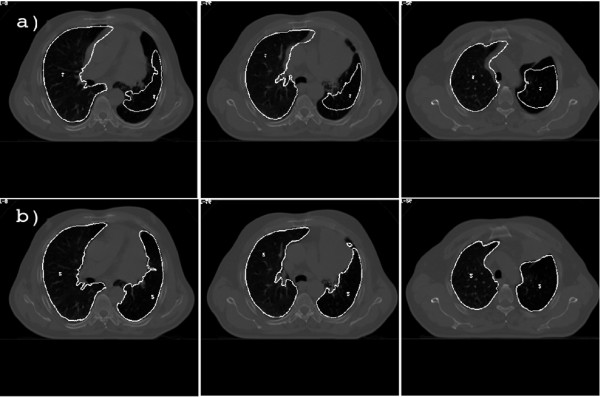
Comparison of lung contours correspondence. kVCT slices for patient 1 with superimposed lung contours extracted from the MVCT after a sole rigid realignment (a) and the elastic method (b). Elastic lung contours well delineate the lung volume on kVCT image while realigned MVCT contours are very different because of mediastinum shift and atelectasis.